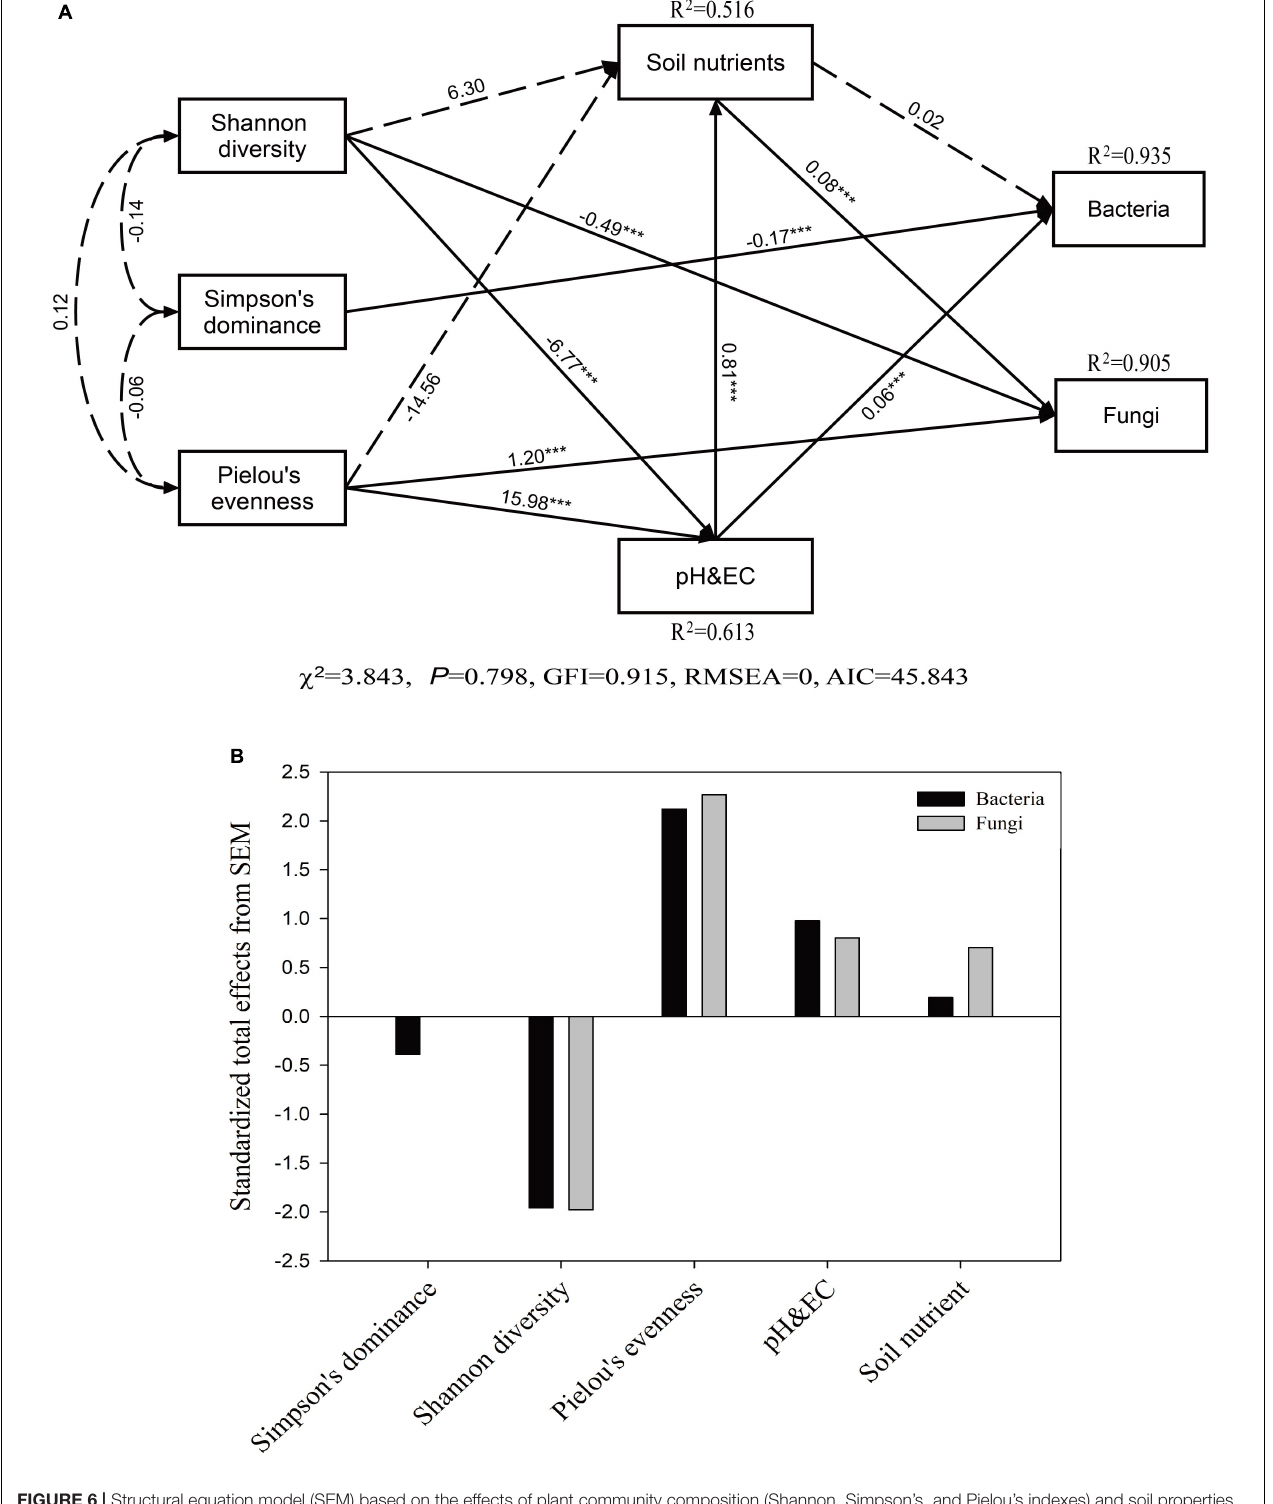
Frontiers in Microbiology |